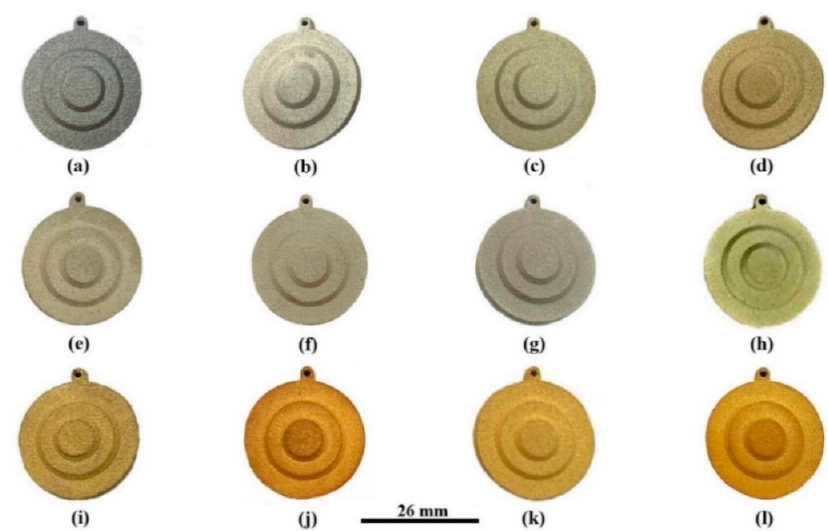
Figure 12. The AM-LPBF AlSi10Mg disk-shaped specimens, coated with electroless Au–Ag film: ( a ) as-printed reference specimen; ( b – d ) specimens coated with 1:1 Ag/Au molar ratio of solution at 80 °C; ( e – h ) coated with 1:2 Ag/Au molar ratio of solution at 80 °C; and ( i – l ) specimens coated with 1:2 Ag/Au molar ratio at 90 °C.